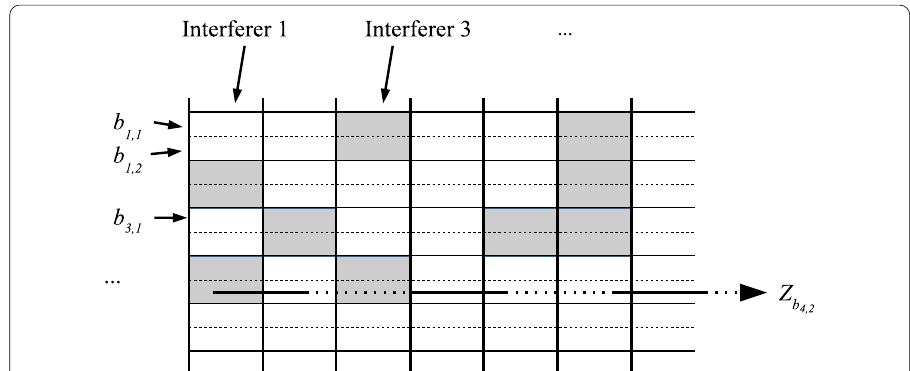
Fig. 2 Illustration of the channel access. The set of 10 subcarriers is considered, with K = 5 msBs of size N = 2 . b u , i is the i ‑th subcarrier from the u ‑th msB, u = 1, ... ,5 . The contribution of each interferer in msBs is shown with gray indicating that the device is active. The resulting interference is a complex vector with NK elements. The element Z u , i corresponds to the sum of all contributions falling in the subcarrier b u ,